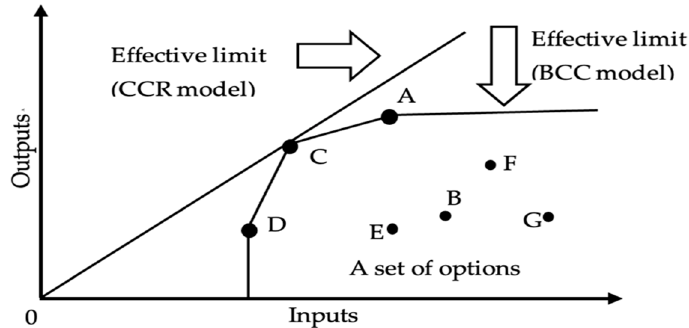
Figure 4. CCR and BCC models shown graphically. (Source: elsevier.com [online]. (accessed on 11 January 2022). Available on the Internet: https://lnk.sk/5789 (accessed on 15 December 2015), own processing). Table 7. CCR and BCC formulas of the output